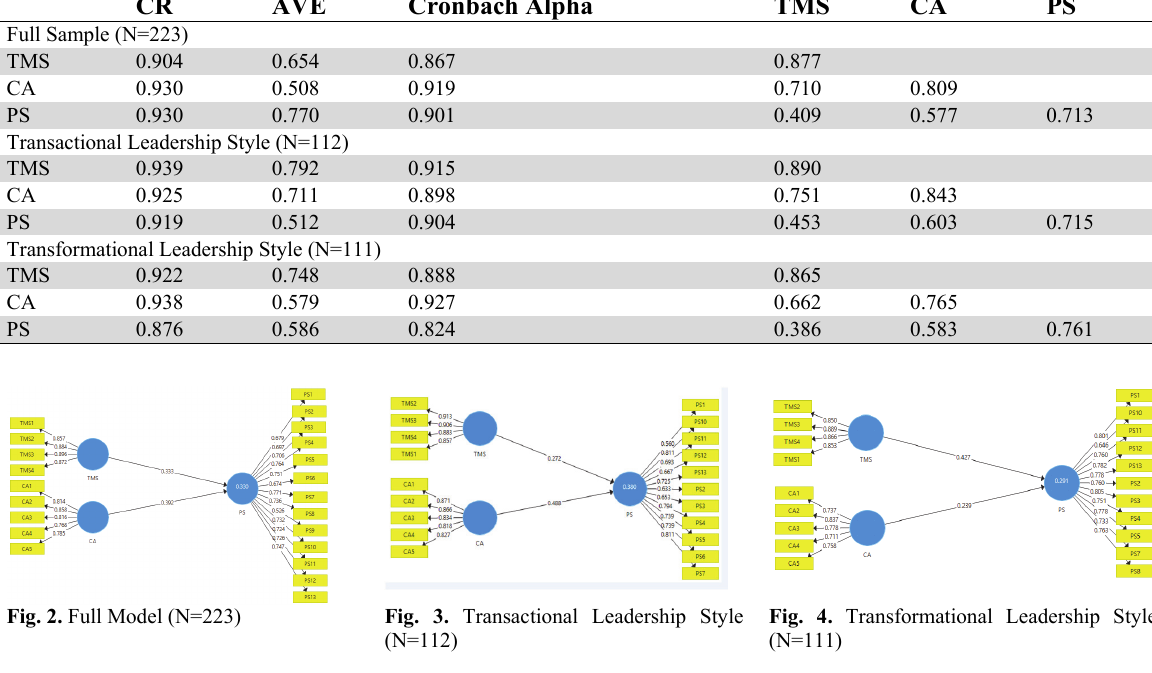
Fig. 2. Full Model (N=223) Fig. 3. Transactional Leadership Style